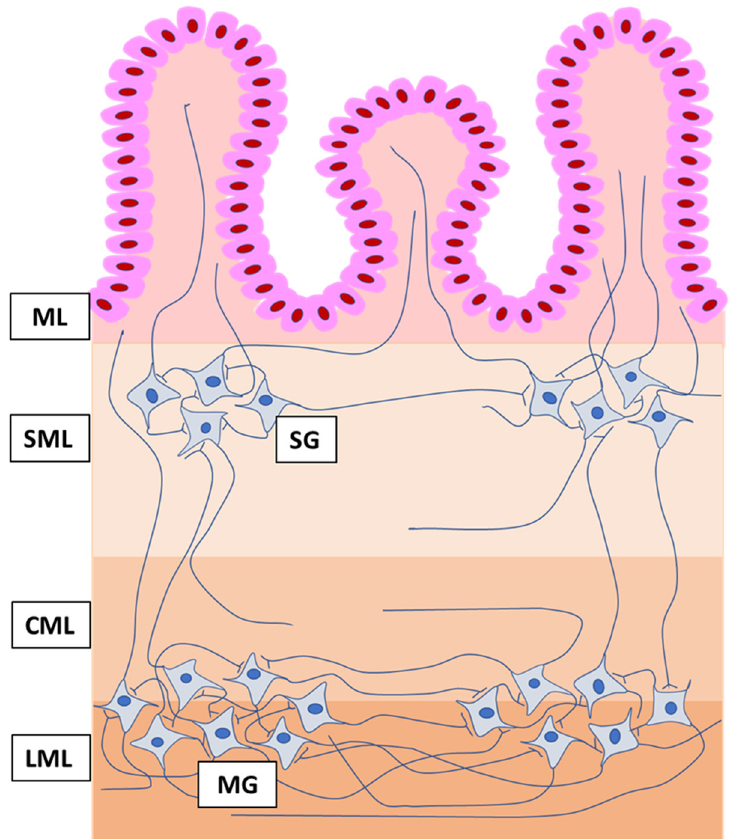
Figure 1. Organization of the enteric nervous system in the wall of the porcine stomach. ML, mucosal layer; SML, submucosal layer; CML, circular muscular layer; LML, longitudinal muscular layer; SG, submucous ganglia; and MG, muscular ganglia, which together with a dense network of fibers connecting ganglia, form the muscular plexus.